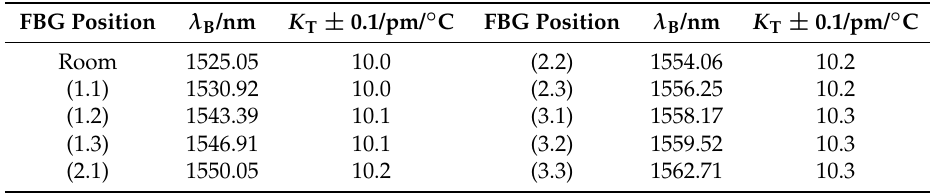
Table 1. Fiber sensors position on the lithium polymer battery (LiPB) with the corresponding Bragg wavelengths and sensitivities obtained through thermal calibration at 20.0 ◦